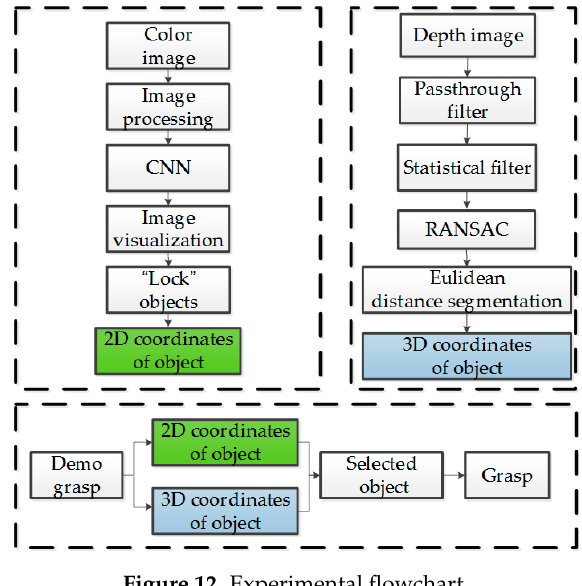
Figure 12. Experimental flowchart.